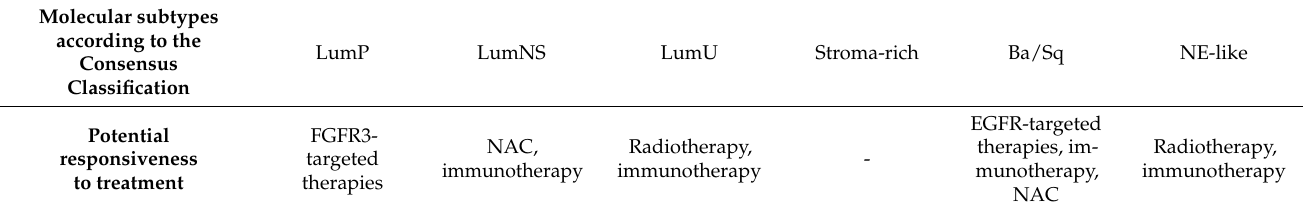
Table 2. Potential responsiveness to different treatments according to the Consensus Classification